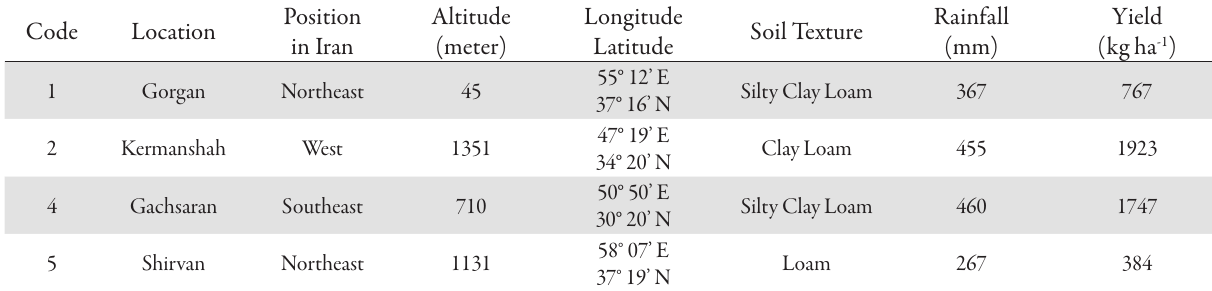
Tab. 2. Geographical properties and mean yield of the 18 lentil genotypes, studied in four locations